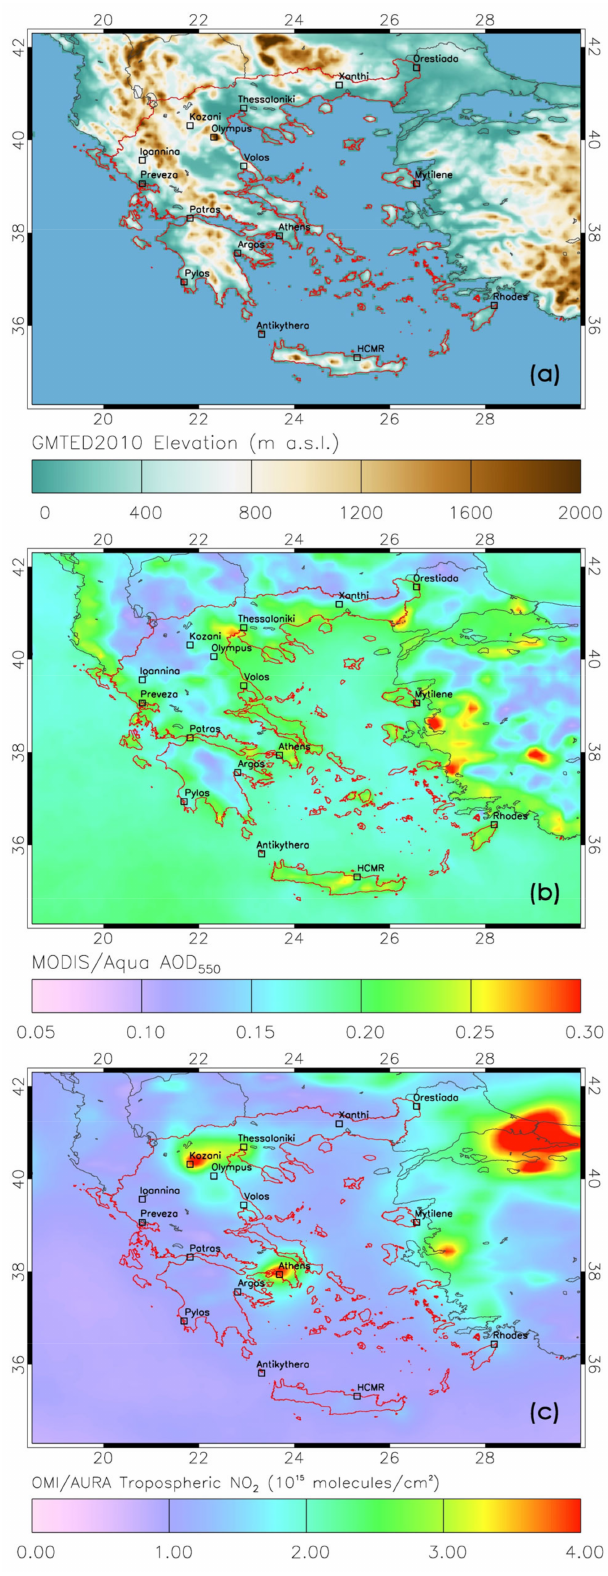
Figure 2. Maps with the ( a ) topography (in meters above sea level—m.a.s.l.), ( b ) annual av- erage MODIS/Aqua AOD 550 , and ( c ) annual average OMI/AURA tropospheric NO 2 VCD (in 10 15 molecules/cm 2 ) over the area of interest for the period 2005–2019. The grid cells with the 16 locations in Greece examined in this work are also